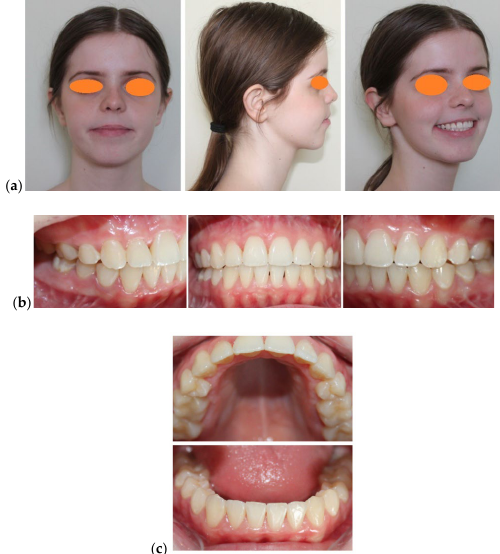
Figure 6. After debonding photographic examination: ( a ) Facial aspect: frontal view, profile, ¾ profile on smiling; ( b ) Intra-oral aspect: lateral right, frontal and lateral left; ( c ) Intra-oral aspect: occlusal view.